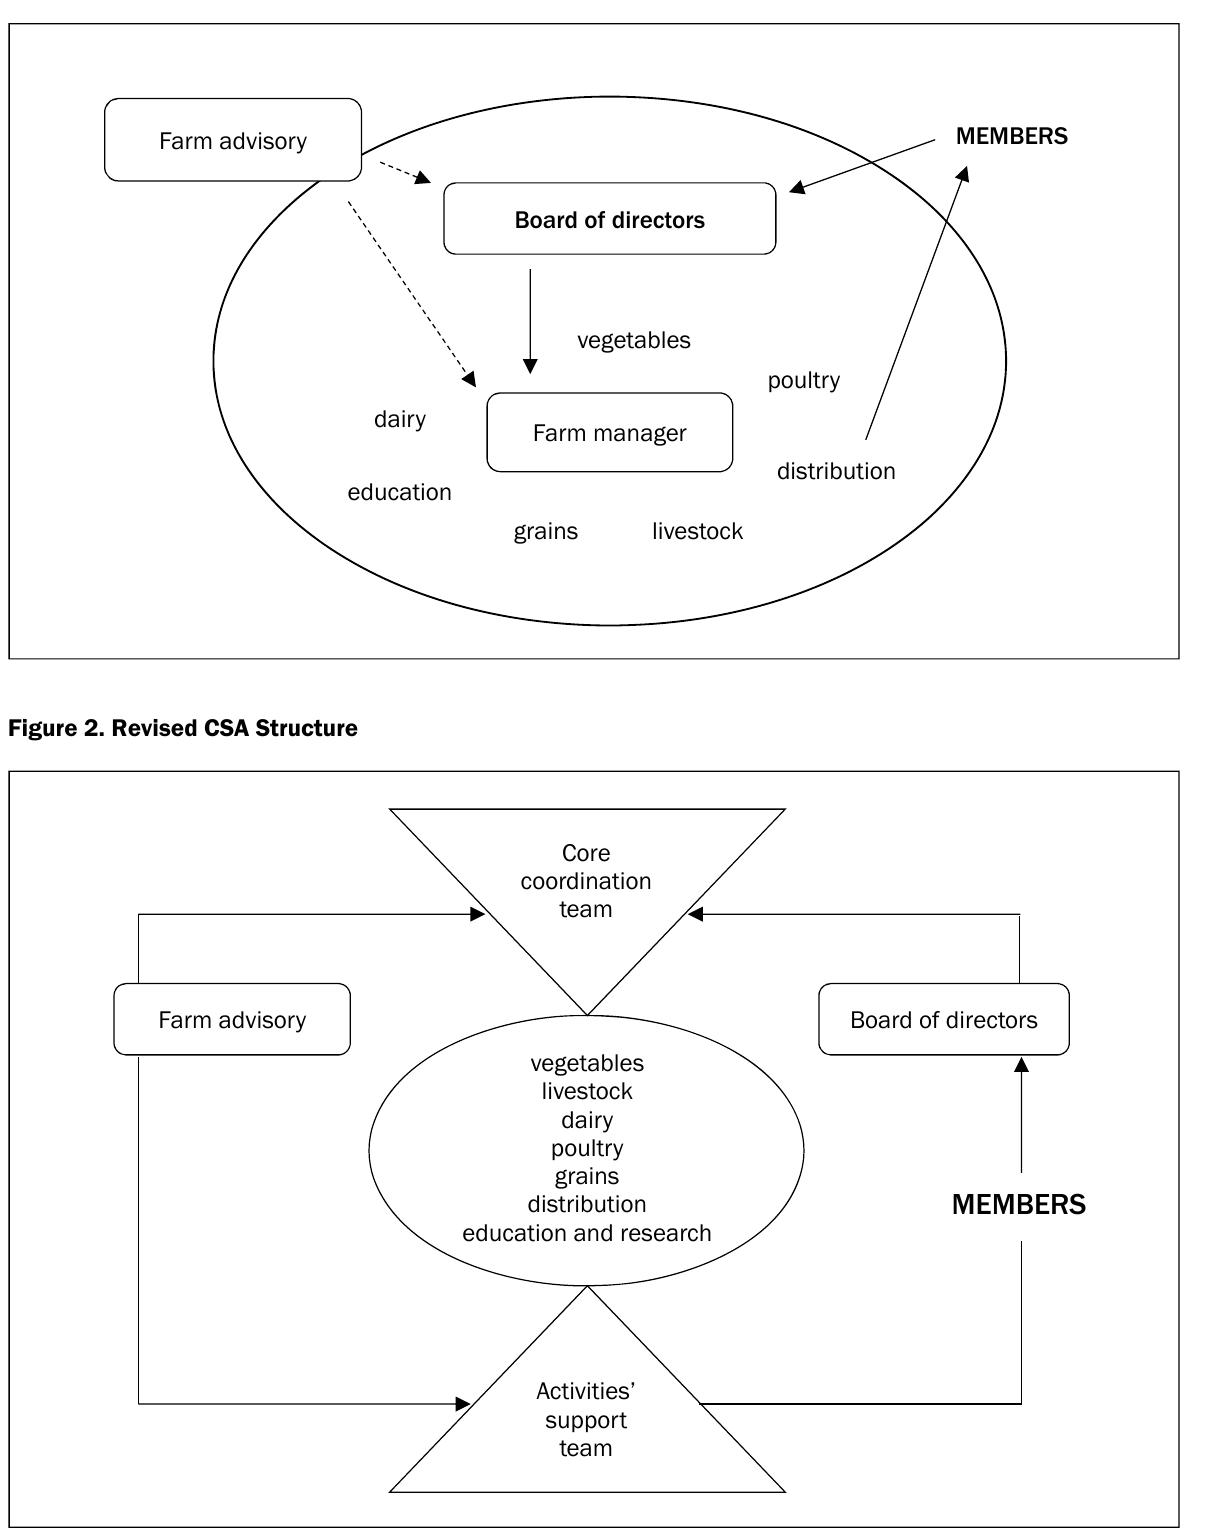
Figure 1. Old CSA Structure